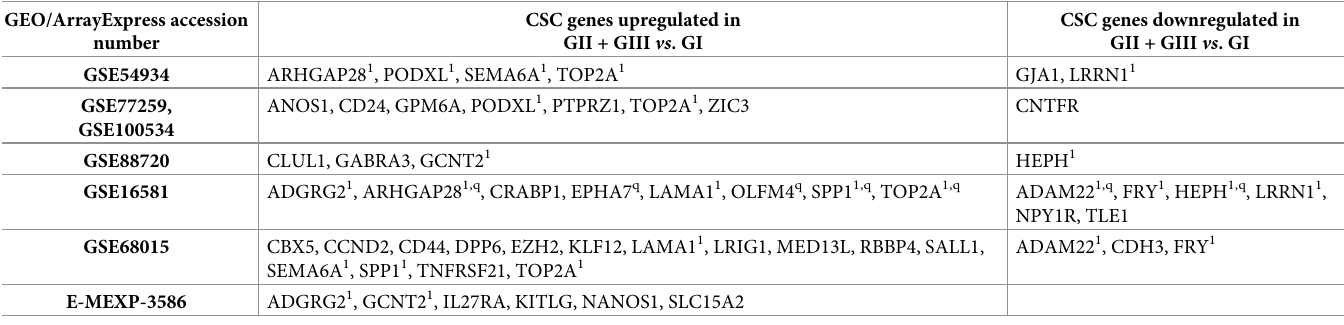
Table 4. CSC genes significantly deregulated in GI vs . GII + GIII comparison groups. GEO/ArrayExpress accession number